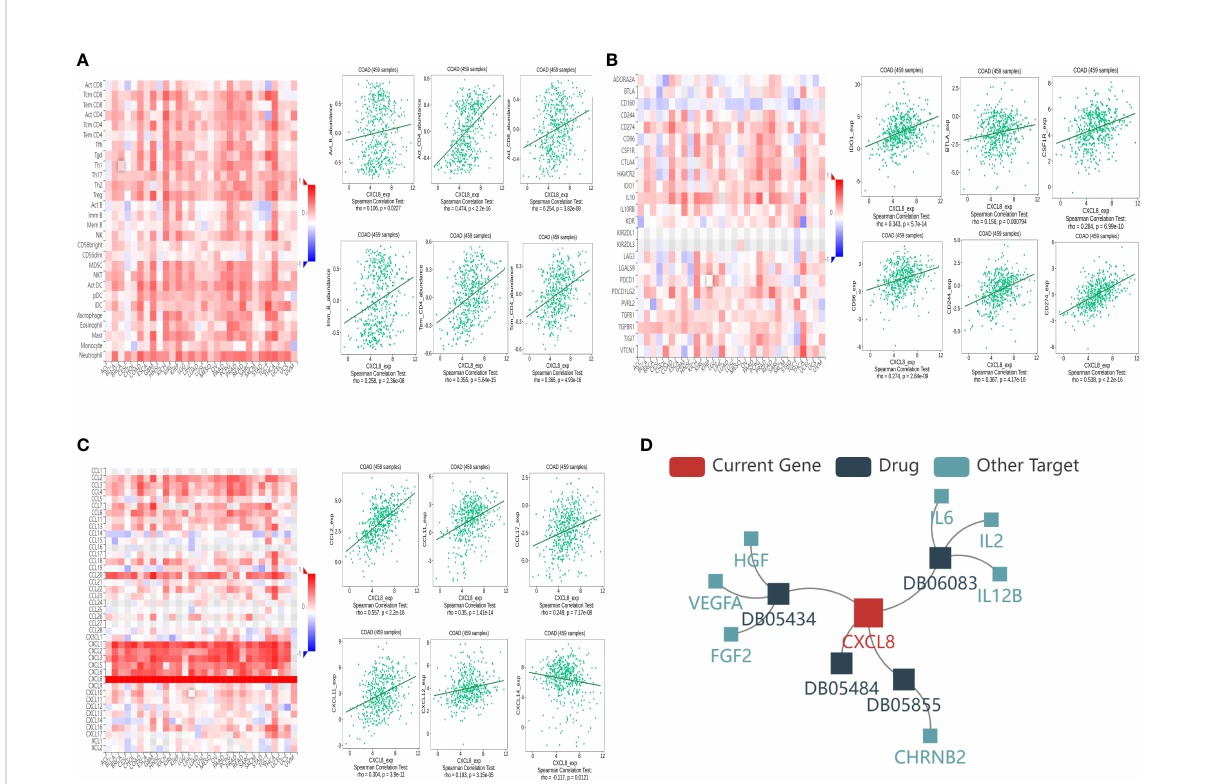
FIGURE 7 Associations of the CXCL8 expression level with lymphocytes, immunomodulators, chemokines, and drugs in COAD from the TISIDB database. (A) Correlations between abundance of tumor ‐ in fi ltrating lymphocytes (TILs) and CXCL8 (plus the six TILs with correlation). (B) Correlations between immunomodulators and CXCL8 (plus the six immunomodulators with correlation). (C) Correlations between chemokines and CXCL8 (plus the six chemokines with correlation, respectively). (D) Correlations between small-molecule drugs and